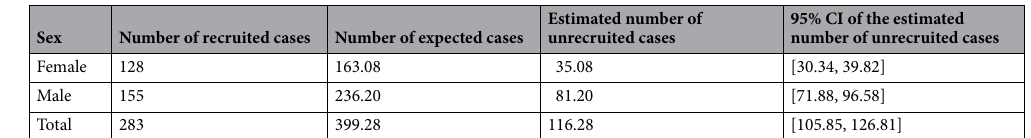
Sex Number of recruited cases Number of expected cases